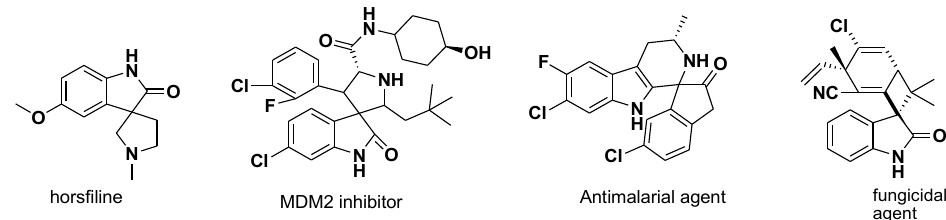
Figure 2. Selected natural and bioactive compounds featuring a spirooxindole motif.